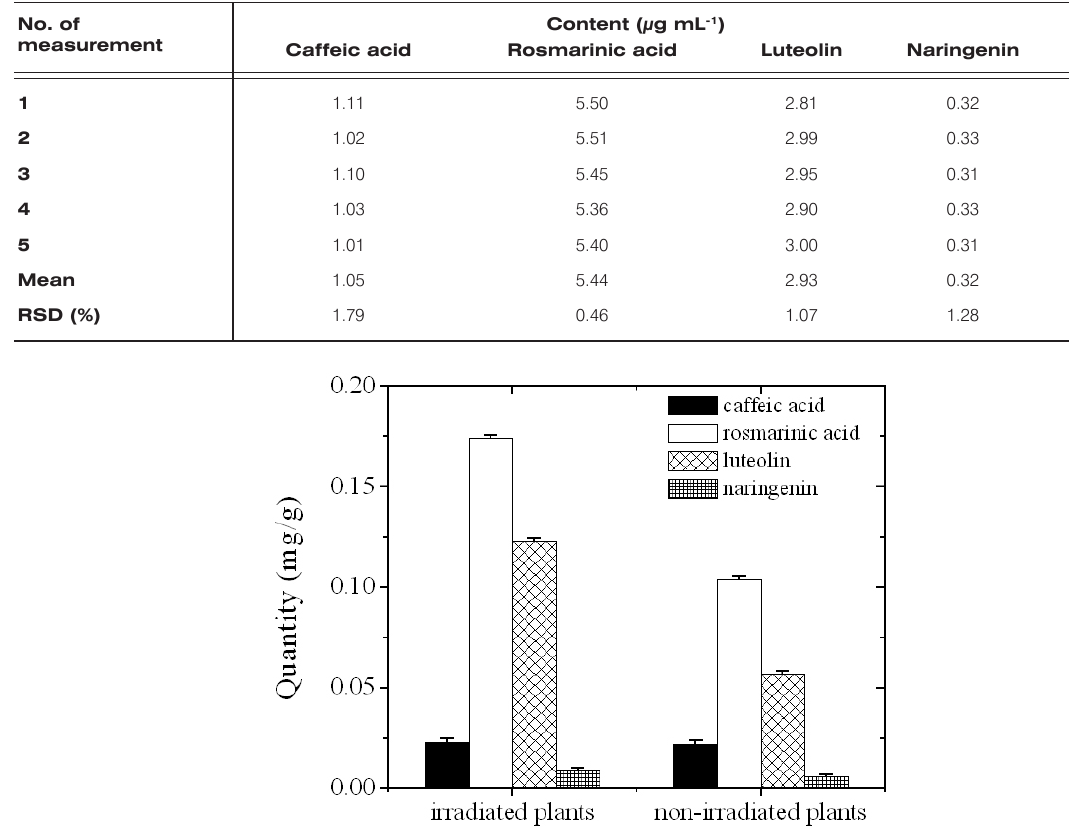
Figure 6. The comparative diagram of the polyphenolic compounds quantity from Satureja hortensis